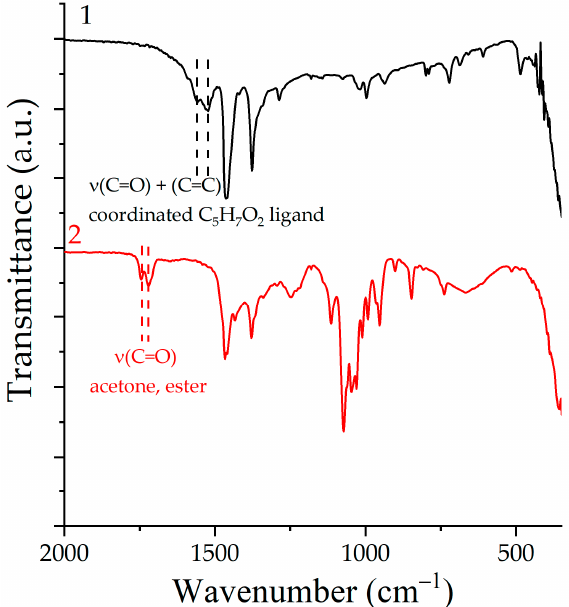
Figure 3. IR spectra of acetylacetonate solution ( 1 ) and the vanadyl alkoxoacetylacetonate solution ( 2 ) obtained as a result of its heat treatment for 18 h. ( 2 ) obtained as a result of its heat treatment for 18